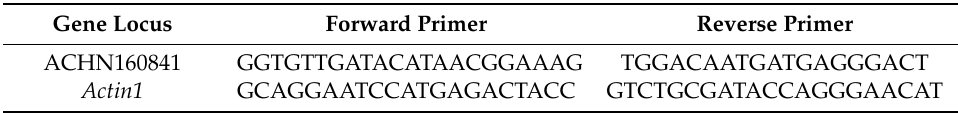
Table 1. qRT-PCR primer